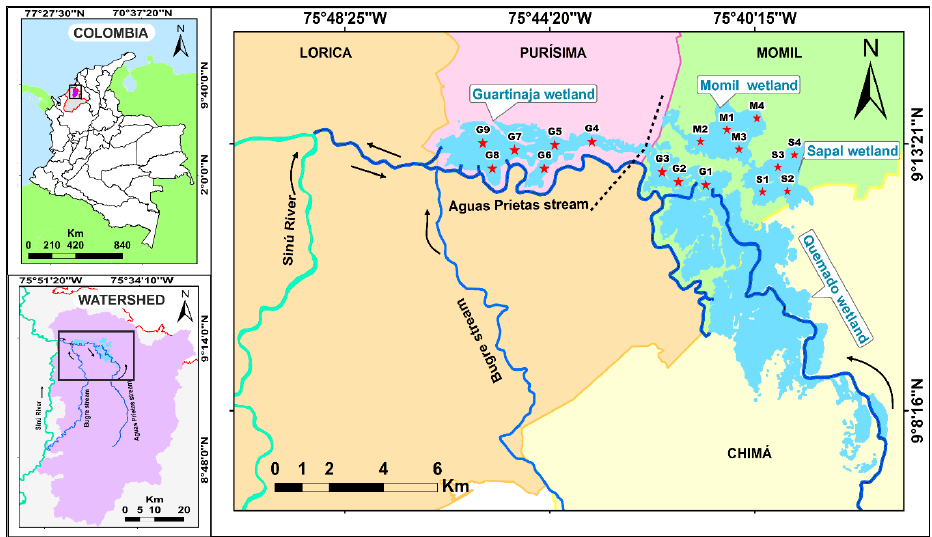
Figure 1. Wetland’s complex location and sampling sites.